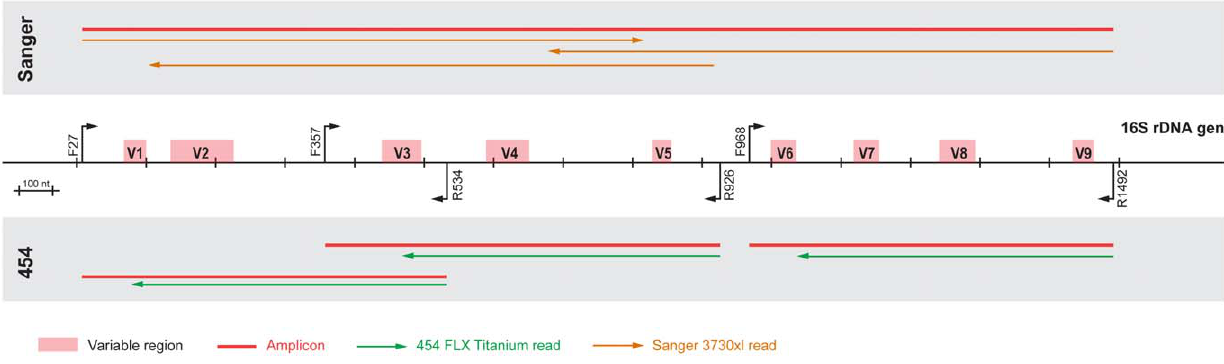
Figure 1. Overview amplicons and reads generated for both the 3730 and 454 sequencing. On a schematic representation of the 16S rDNA gene, the known variable regions and the primers used in this study are indicated. Positions and numbering are based on the Escherichia coli reference sequence. The amplicons generated by each primer set are marked in red, and sequencing directions and expected lengths are indicated in orange for 3730 and green for 454.